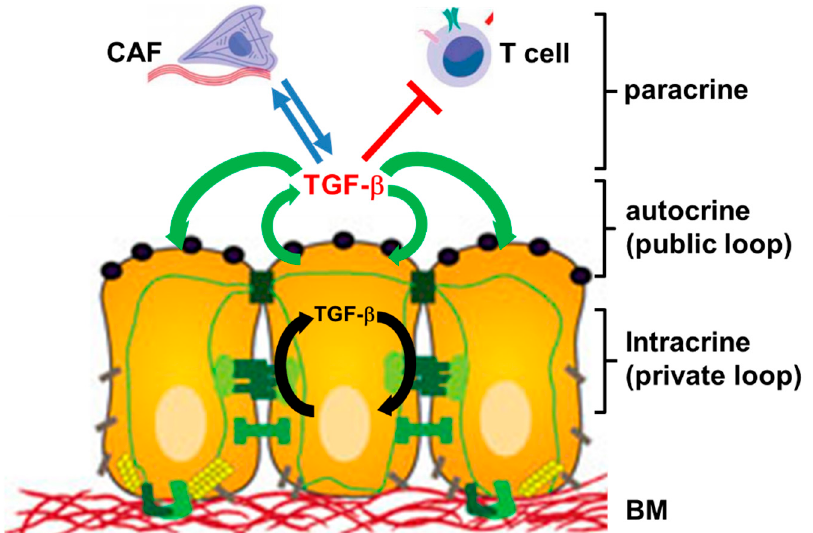
Figure 1. Cartoon illustrating the principles of autocrine, intracrine and paracrine TGF ‐β signaling. Autocrine interactions are indicated by green arrows, intracrine interactions by black arrows, and paracrine interactions by blue arrows (stimulatory) or red lines (inhibitory). Paracrine interactions can be unidirectional or bidirectional/reciprocal. CAF, cancer ‐ associated fibroblast; BM, basement membrane.